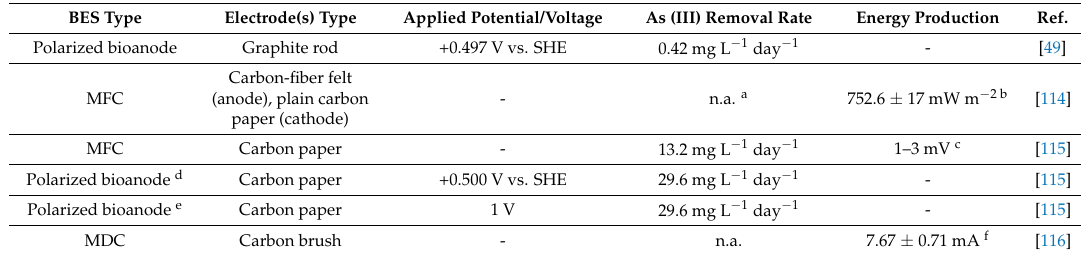
Table 2. Arsenic removal using bioelectrochemical systems